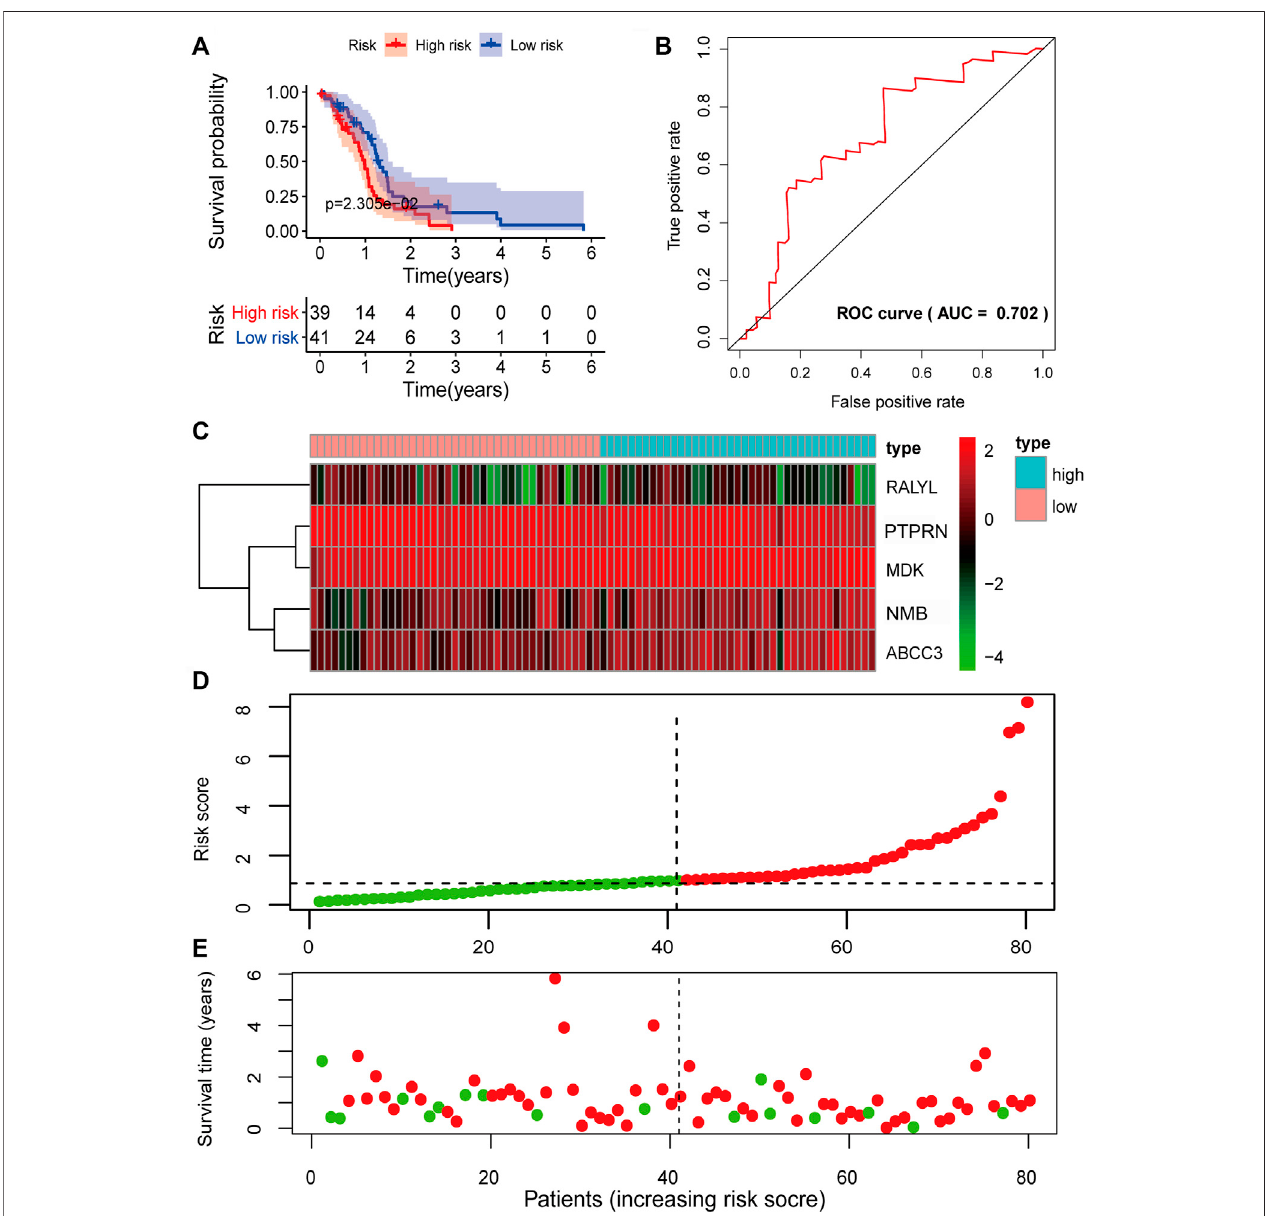
FIGURE5| Prognosticevaluationofthe fi ve-mRNAsignatureinthetestingset. (A) Kaplan – Meiersurvivalcurveforpatientoverallsurvival(OS)inthetestingset. (B) Receiver operating characteristic (ROC) curve analysis to compare the sensitivity and speci fi city of the prognosis prediction model. The mRNA expression patterns (C) , risk score distribution (D), and survival status of patients (E) in the high- and low-risk groups by the fi ve-mRNA signature. Green dot, alive; red dot, dead.